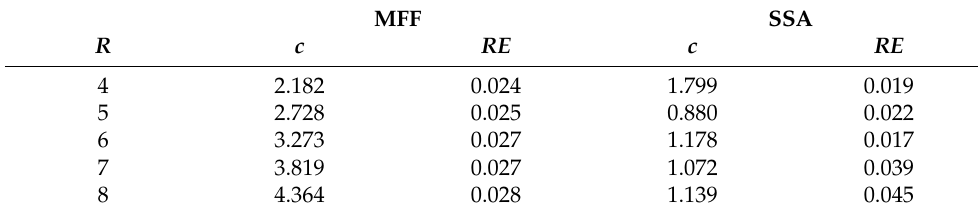
Table 2. Relative errors by comparing with the FEM.